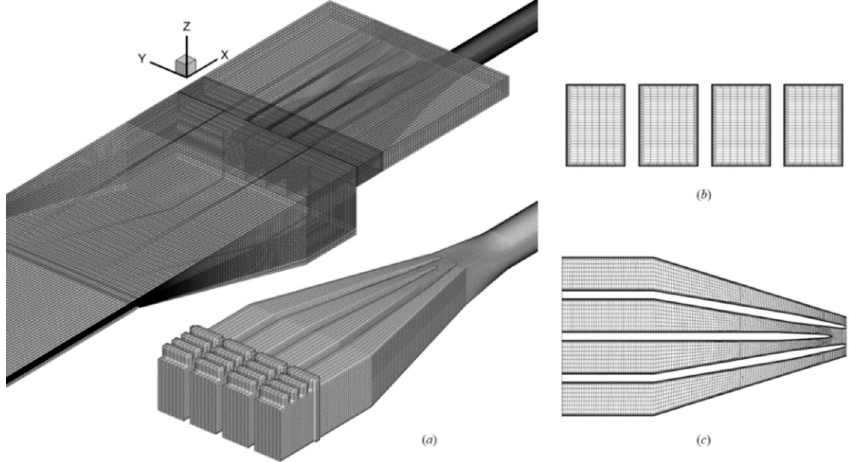
Figure 3. Grids generation for the computational domain: ( a ) grids on the boundary; ( b ) grids at the orifice cross-section, and ( c ) grids on the orifice horizontal section.